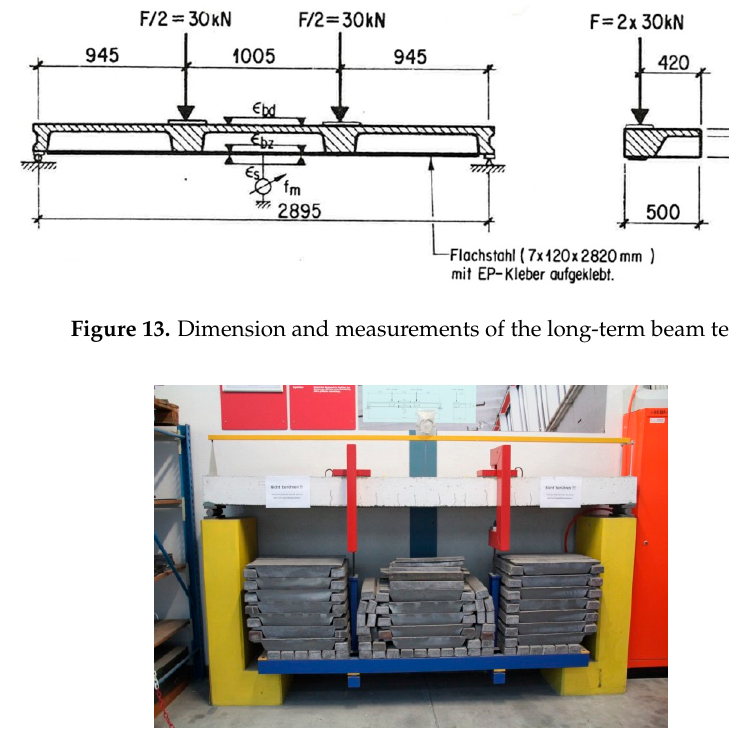
Figure 14. Long-term test at Empa: RC beam strengthened with a bonded steel plate under a sustained load.